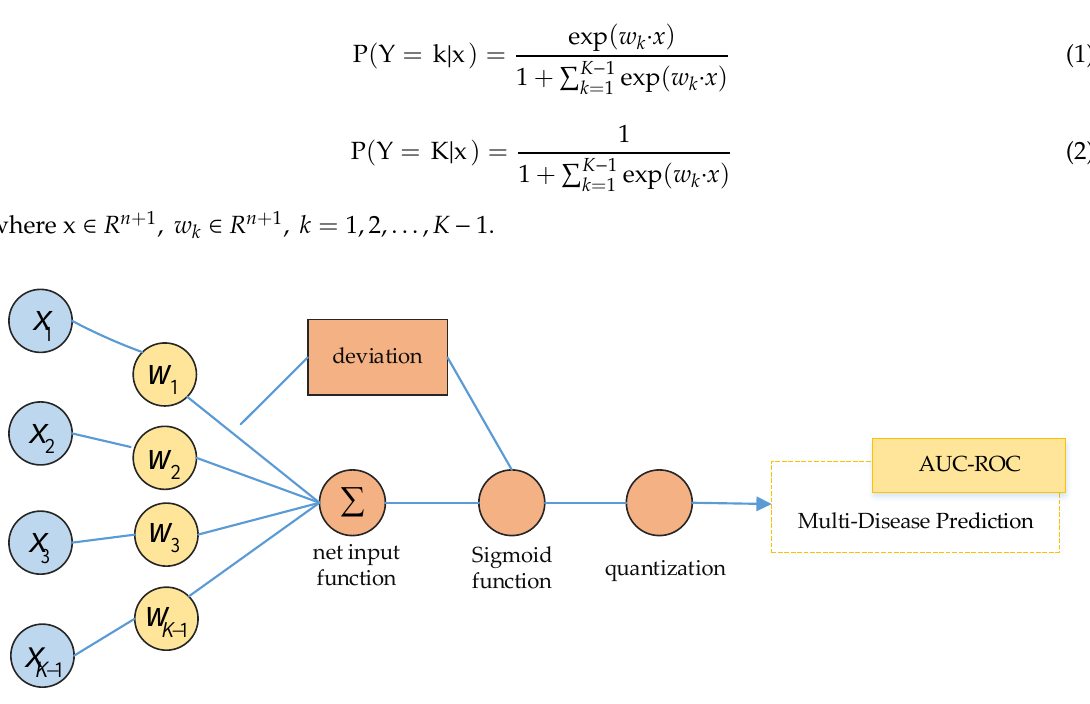
Figure 3. Multinomial logistic regression model.